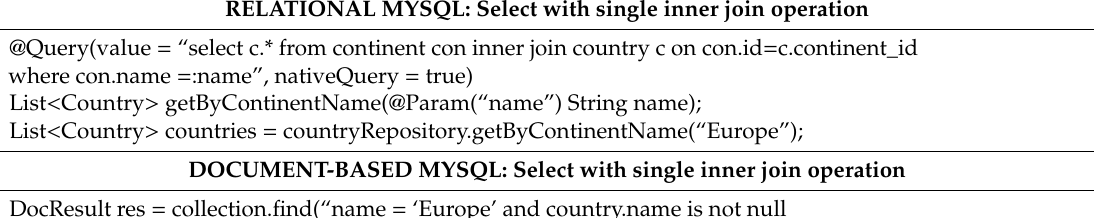
Table 5. Select with single inner join operations.